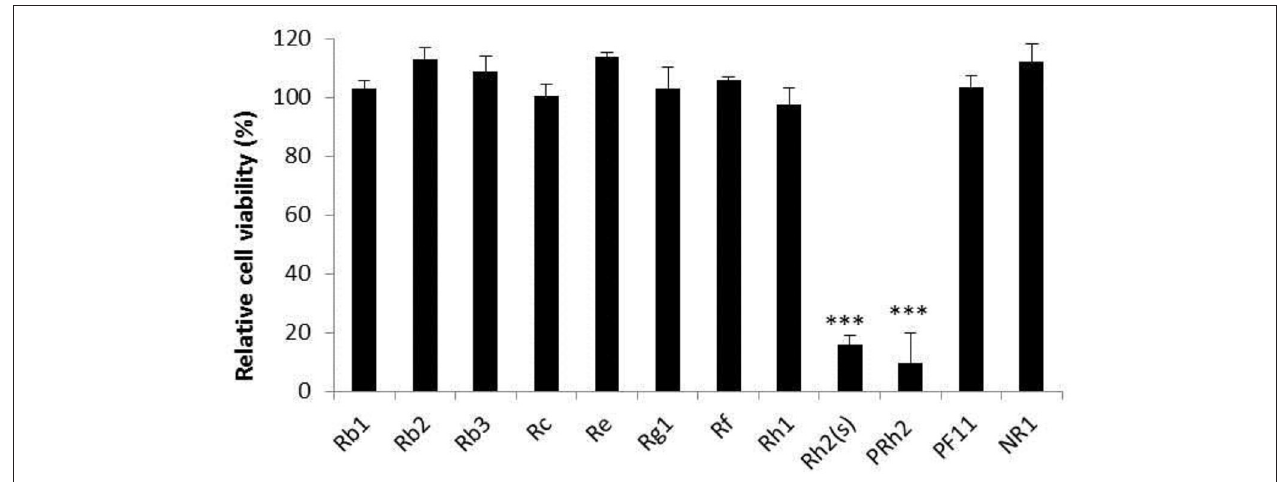
FIGURE 1 | Cytotoxicity of compounds. The result of cell viability is expressed as the percentage of control. The data are expressed as the mean of three experiments. *** p < 0.001. PRh2, pseudoginsenoside Rh2; PF11, pseudoginsenoside F11; NR1, notoginsenosideR1